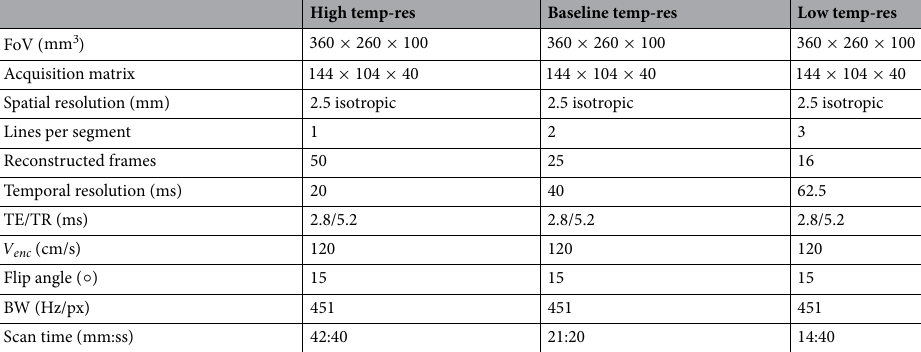
Table 1. 4D-flow MRI sequence parameters. Three data sets were acquired with each model, resulting in a total of nine datasets available for analysis. Variations in effective temporal resolution were controlled by the number of acquired k-space lines per segment, and the number of reconstructed cardiac frames was adapted accordingly. FOV field of view, TE echo time, TR repetition time, V enc velocity encoding range, BW